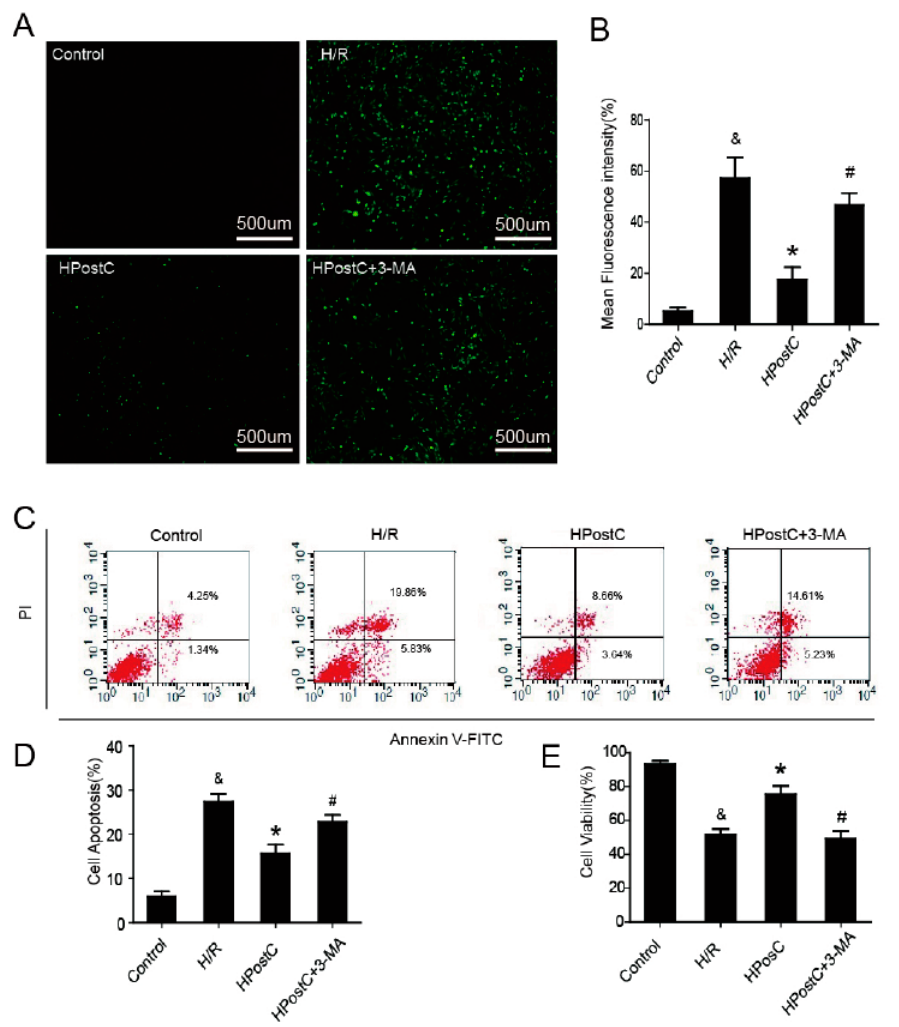
Figure 6. HPostC protected H9c2 cells by promoting autophagy in vitro. ( A , B ) ROS production was detected in H9c2 cells at 30 min of reoxygenation; ( C ) H9c2 cells were collected and stained with